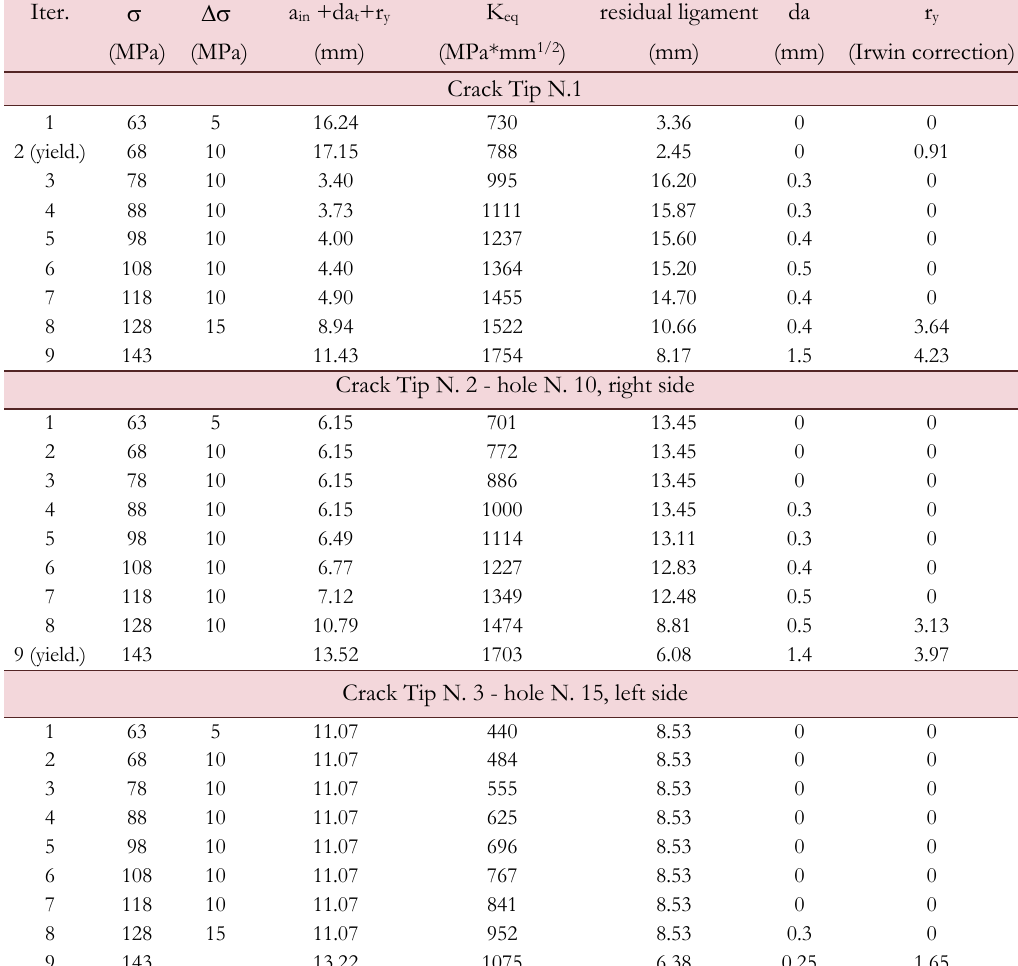
Table 1: Crack advance vs. monotonic increasing